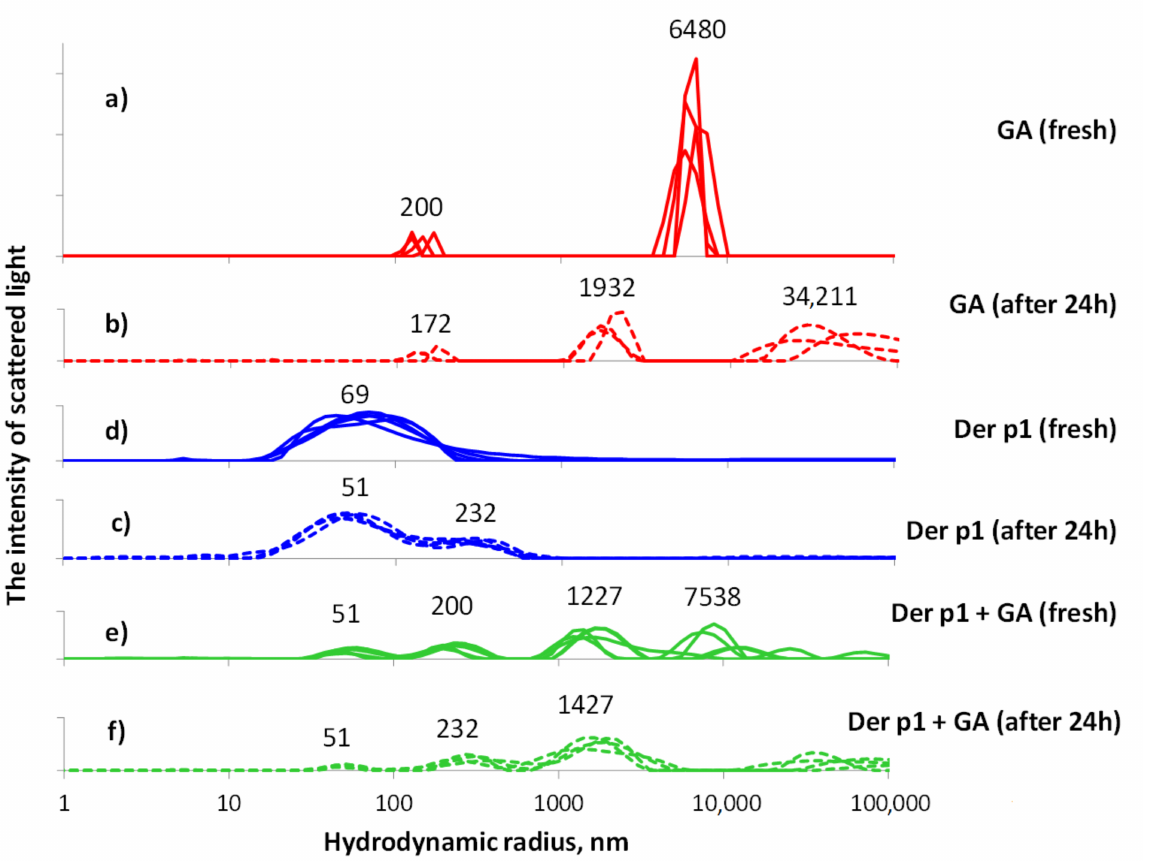
Figure 1. Measurement of particle size in solution by light scattering. We studied aqueous solutions of peptide 10 µ g/L (blue curves), GA 100 µ g/L (red curves), and a solution obtained by mixing two previous solutions 1:1 (green curves). In each solution, measurements were carried out twice: 1–5 h after preparation (solid line), and one day after preparation (dashed line). All distributions on the graph are normalized. The measurement results show the presence of several sizes of associates in